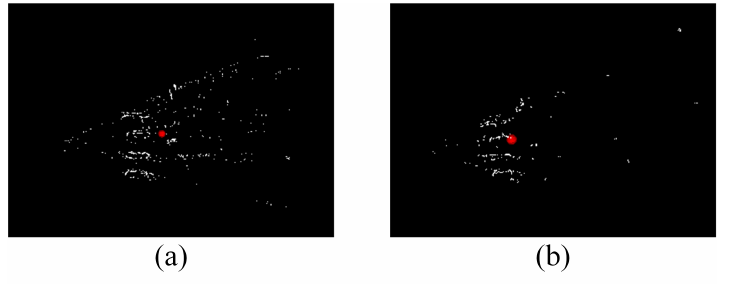
Figure 6. Visualization of semantic positioning process. ( a ) Unfiltered point cloud and centroid (red dot) of the RoI in single batch. ( b ) The point cloud and its centroid after statistical